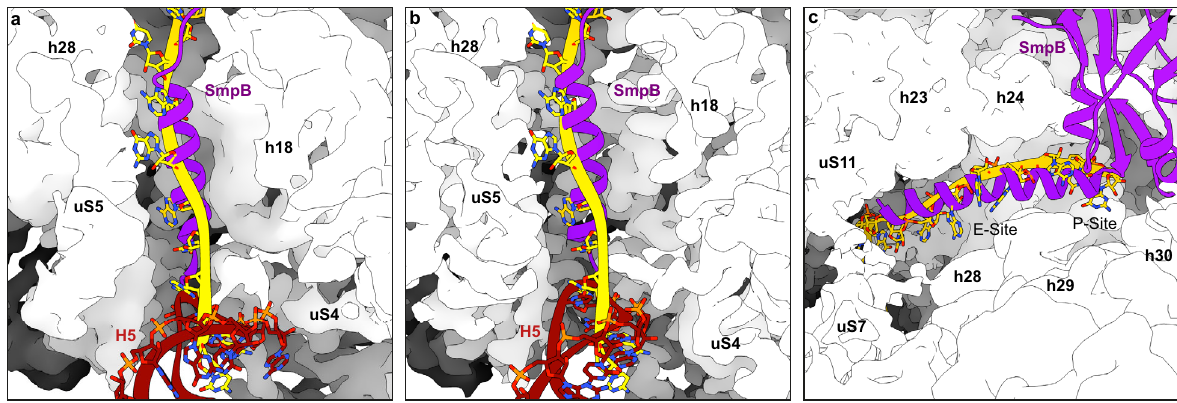
Fig. 9 Close-up of the mRNA path during trans -translation. In the a pre-accommodation and b accommodation states, the C-terminal tail of SmpB (purple) occupies the mRNA channel, while the H5 stem-loop of tmRNA (red) closes the entrance. Both domains would clash with a canonical mRNA (yellow, PDB code 6ZTJ 88 ), forcing the selection of stalled ribosomes. c After translocation, the C-terminal tail is rotated by 62° and deeply inserted into the mRNA exit tunnel. There again, it clashes with the mRNA (PDB code 7JT1 89 ), resulting in the ejection of the non-stop mRNA from the ribosome. The cryo-electron density map of the 30S small subunit is shown as a white